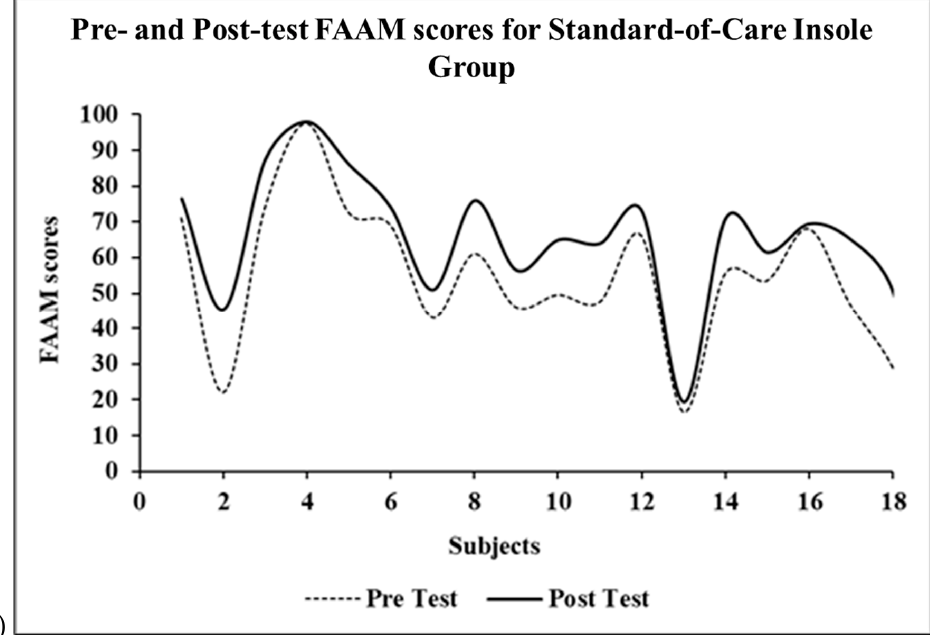
Figure 6. Pre-test and post-test functionality scores of subjects wearing ( A ) 3D-printing-based customized and ( B ) standard-of-care insoles .